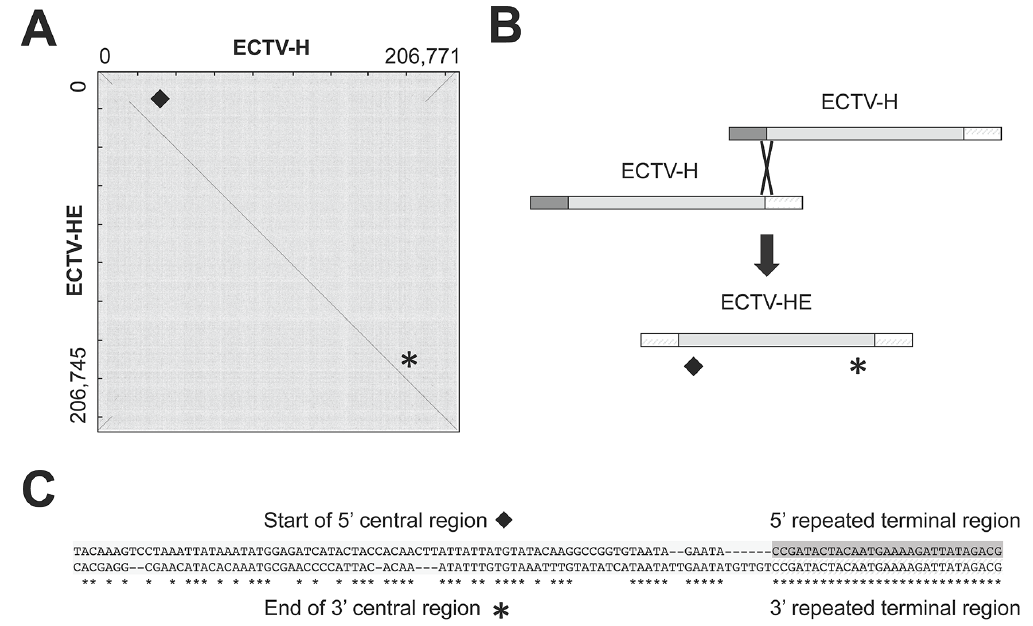
Figure 4. Genomic comparison of ECTV-H and ECTV-HE. ( A ) Dot plot of ECTV-H vs. ECTV-HE. The dot plot compares two sequences by organizing one sequence on the x-axis, and another on the y-axis, of a plot. When the nt of both sequences match at the same location on the plot, a dot is drawn at the corresponding position. ( B ) Schematic representation of the proposed genomic recombination between two ECTV-H genomes to generate ECTV-HE. ( C ) Alignment of two representative reads that share the end of the repeated terminal region of ECTV-HE and differ in the beginning of the central region of the genome. An asterisk and a diamond indicate the approximated region where the aligned reads derived.